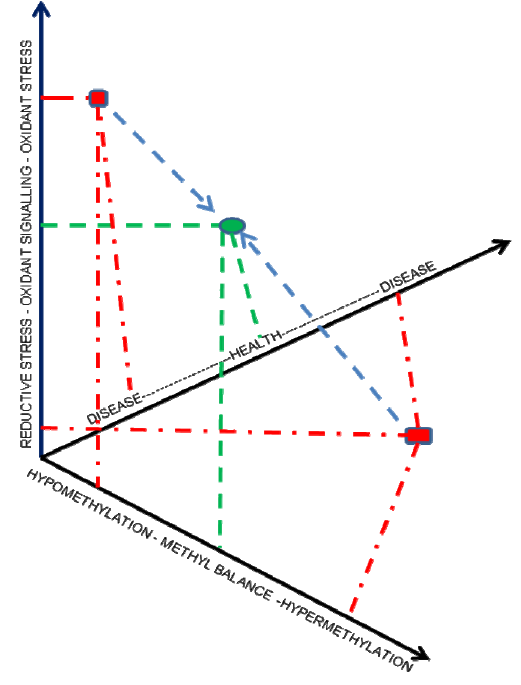
Figure 3. Selenistasis—Selenium integrates redox-methylation balance in health and disease. The X-axis represents methylation status, the Y-axis represents redox state, and the Z-axis represents the continuum from health to disease states. The green oval represents normal oxidant signaling and methylation balance in health. The red square and red rectangle represent two possible combinations of changes in redox and methylation states in disease. Blue arrows delineate the desired effect of interventions in diseased states, i.e. , to alter redox and methylation states and, thereby, approximate